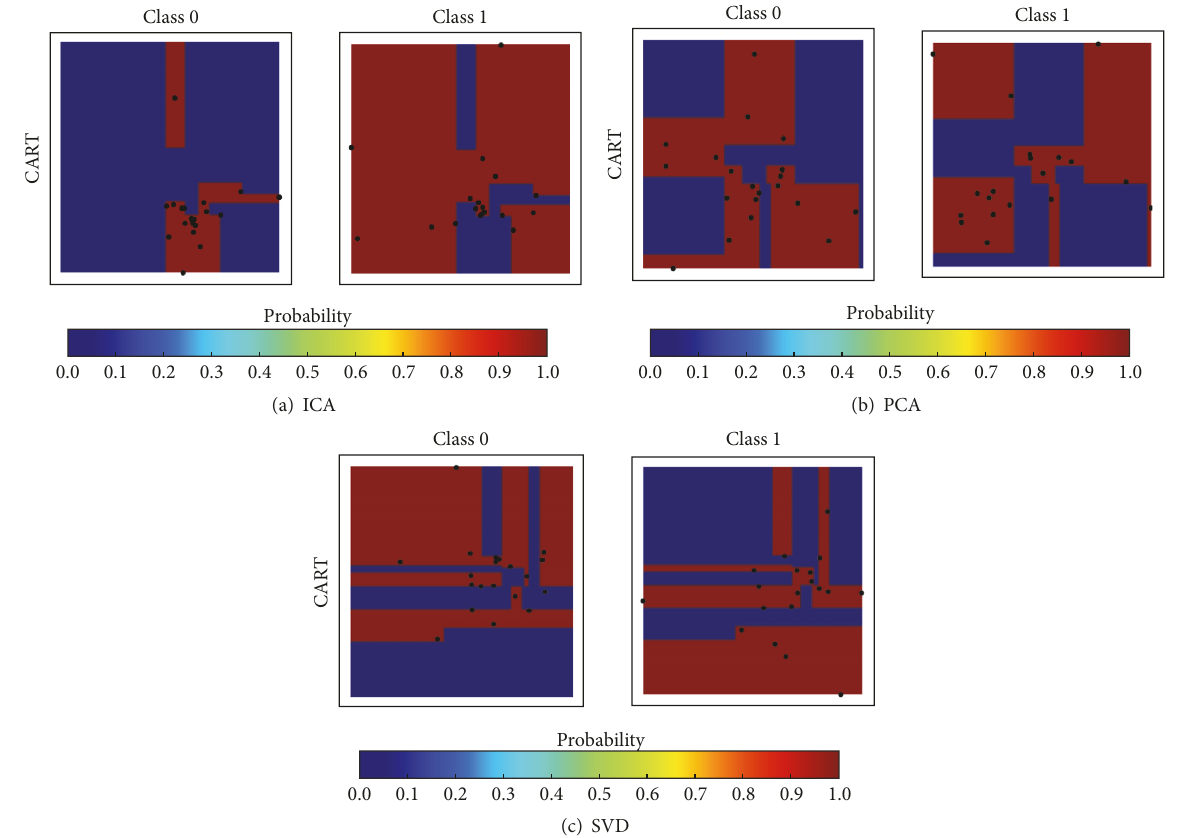
Figure 7: Contour plots of probability surface for classification using the CART for ICA, PCA, and SVD data reduction